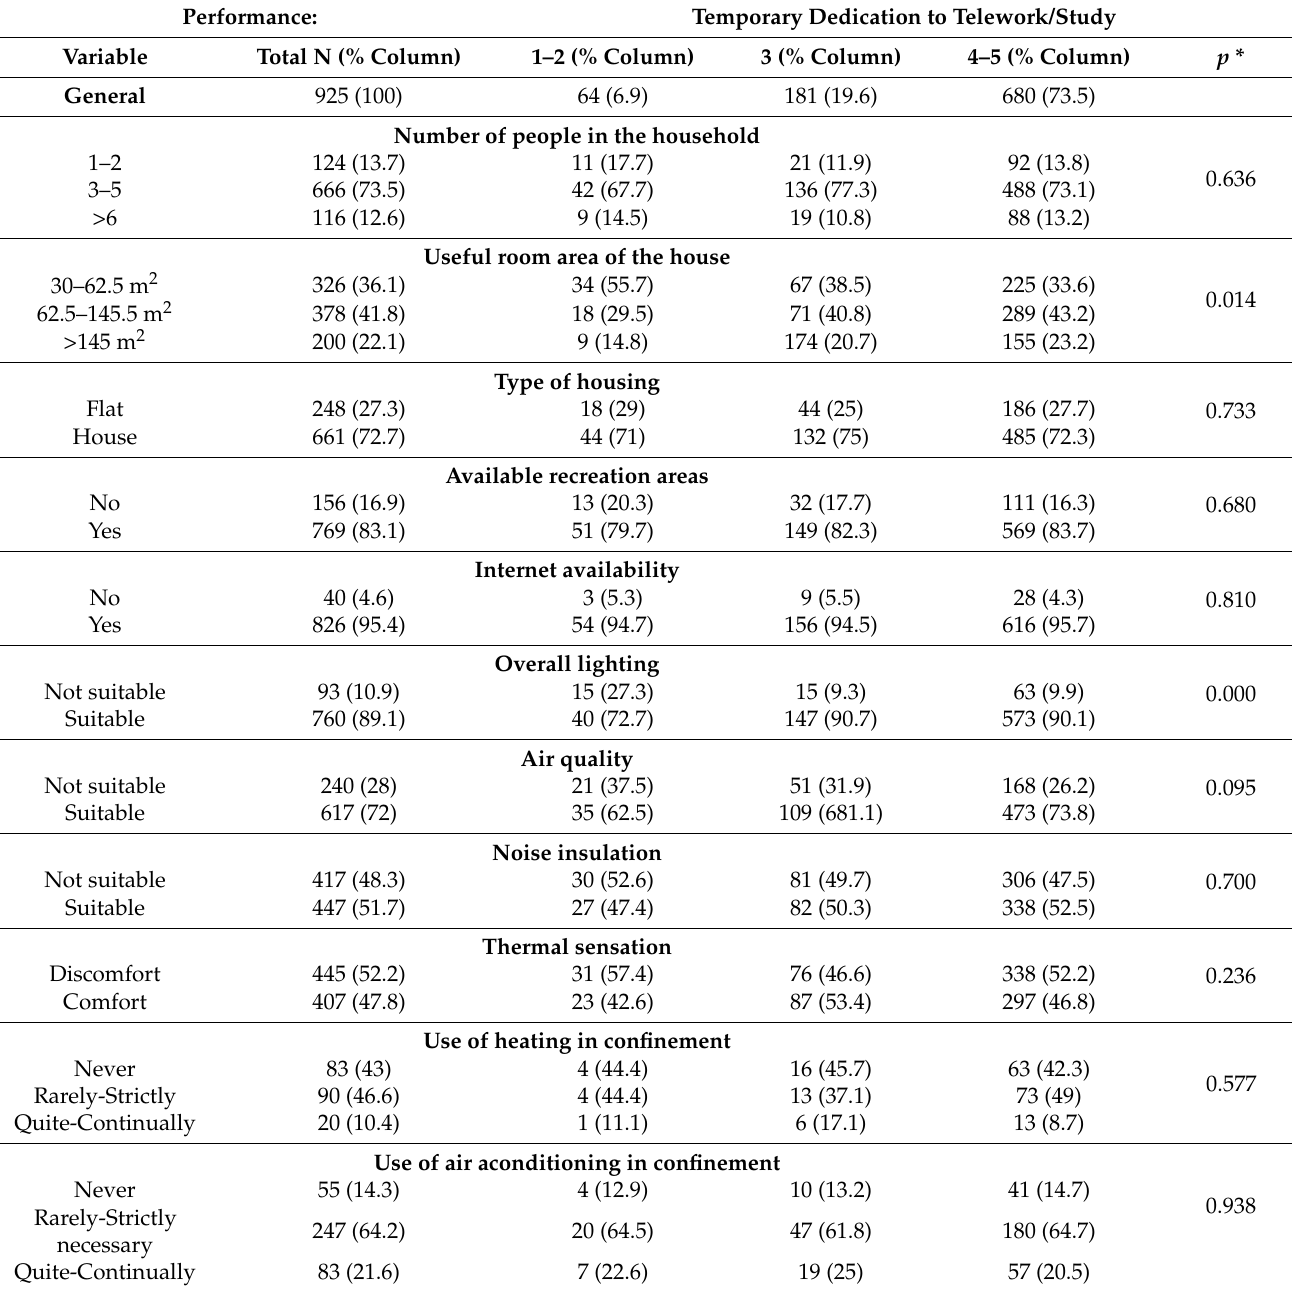
Table 3. Relationships among home features and